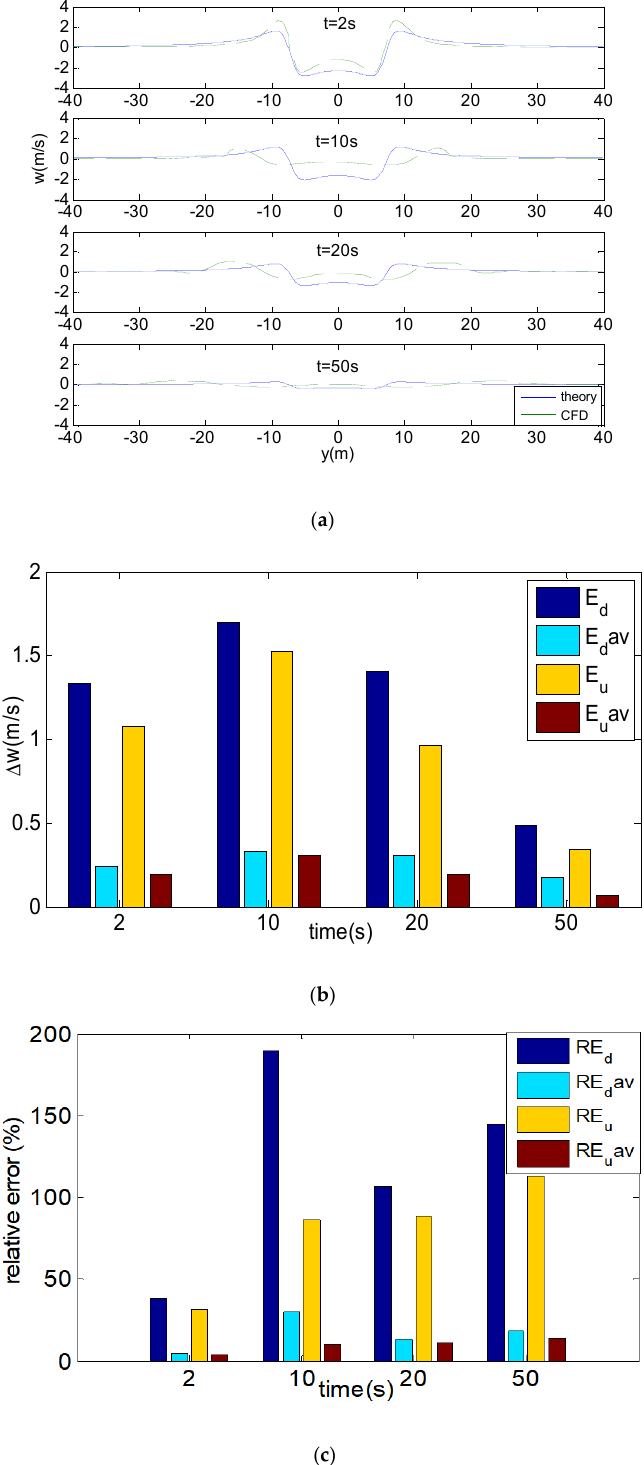
Figure 7. Induced velocity in far-field and error between theory and CFD [14] of Thrush 510G above the ground 3 m: ( a ) velocity profile (spanwise) over time corresponding downstream x = 7.6 b , 38 b , 76 b , 190 b ; ( b ) absolute error over time, E d : maximal error of downwash on y -axis, E u : maximal error of upwash on y -axis, E d av: average error of downwash on y -axis, E u av: average error of upwash on y -axis; ( c ) relative error over time, RE d : maximal relative error of downwash on y -axis, RE u : maximal relative error of upwash on y -axis, RE d av: average relative error of downwash on y -axis, RE u av: average relative error of upwash on y -axis.